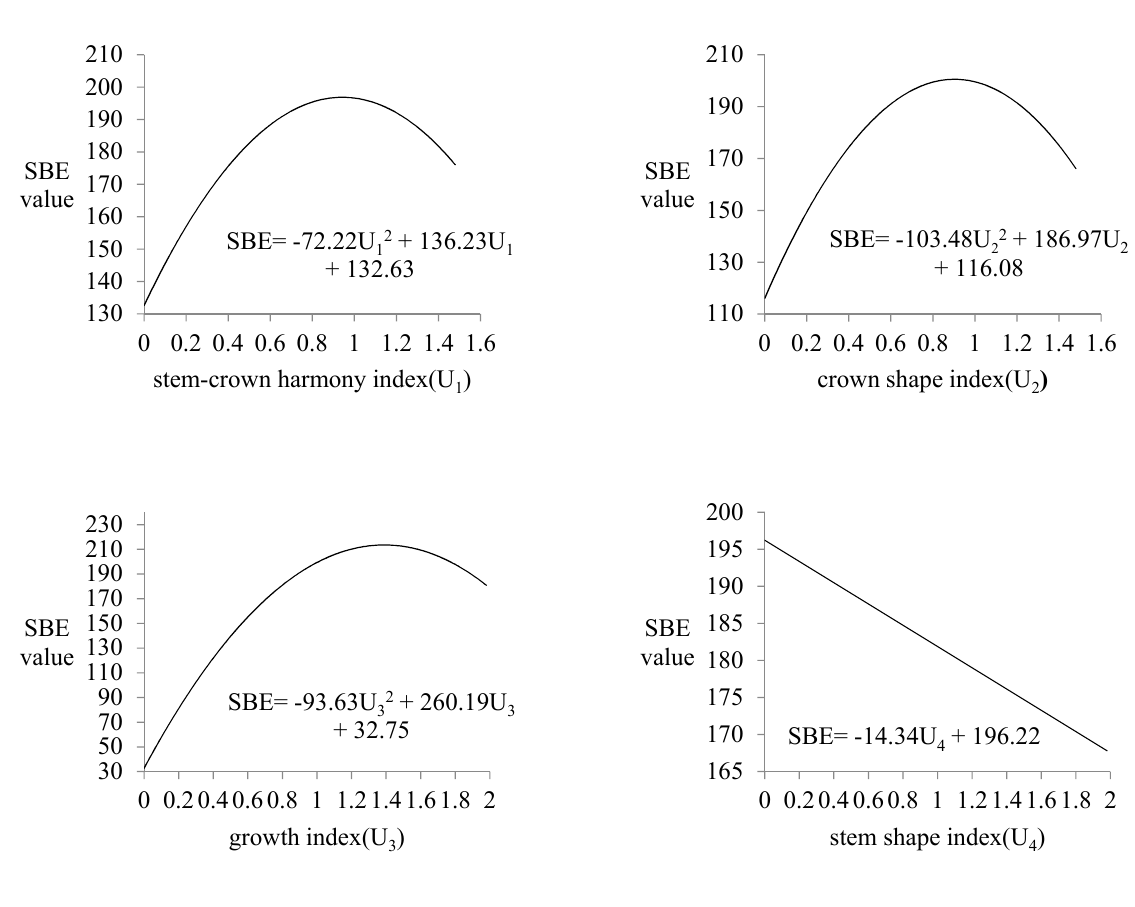
Figure 1. The relationship between four indices and SBE value change